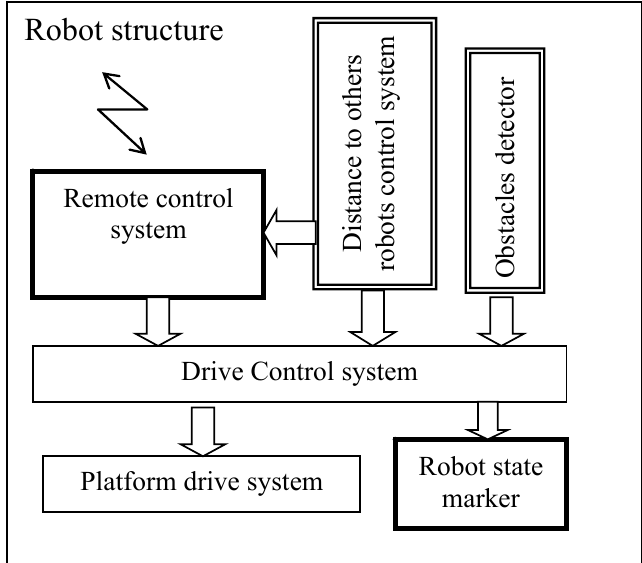
Figure 17. The robot structure for a nonhierarchical swarm.